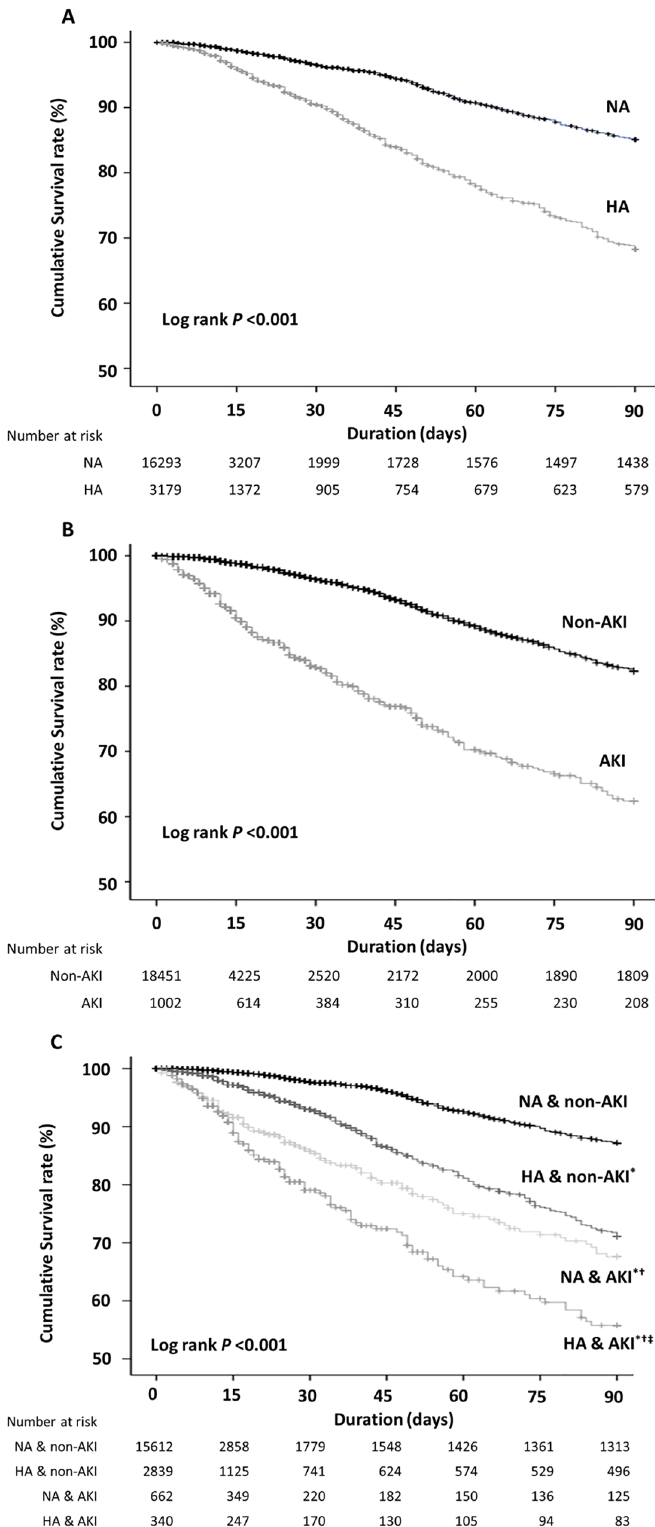
Fig 4. Cumulativesurvivalrateaccording to the serumalbumin and acutekidneyinjury groups. A, B, andC showthe survivalcurvesof theserum albumin,AKI, andcombinedalbuminandAKI groupsfor the